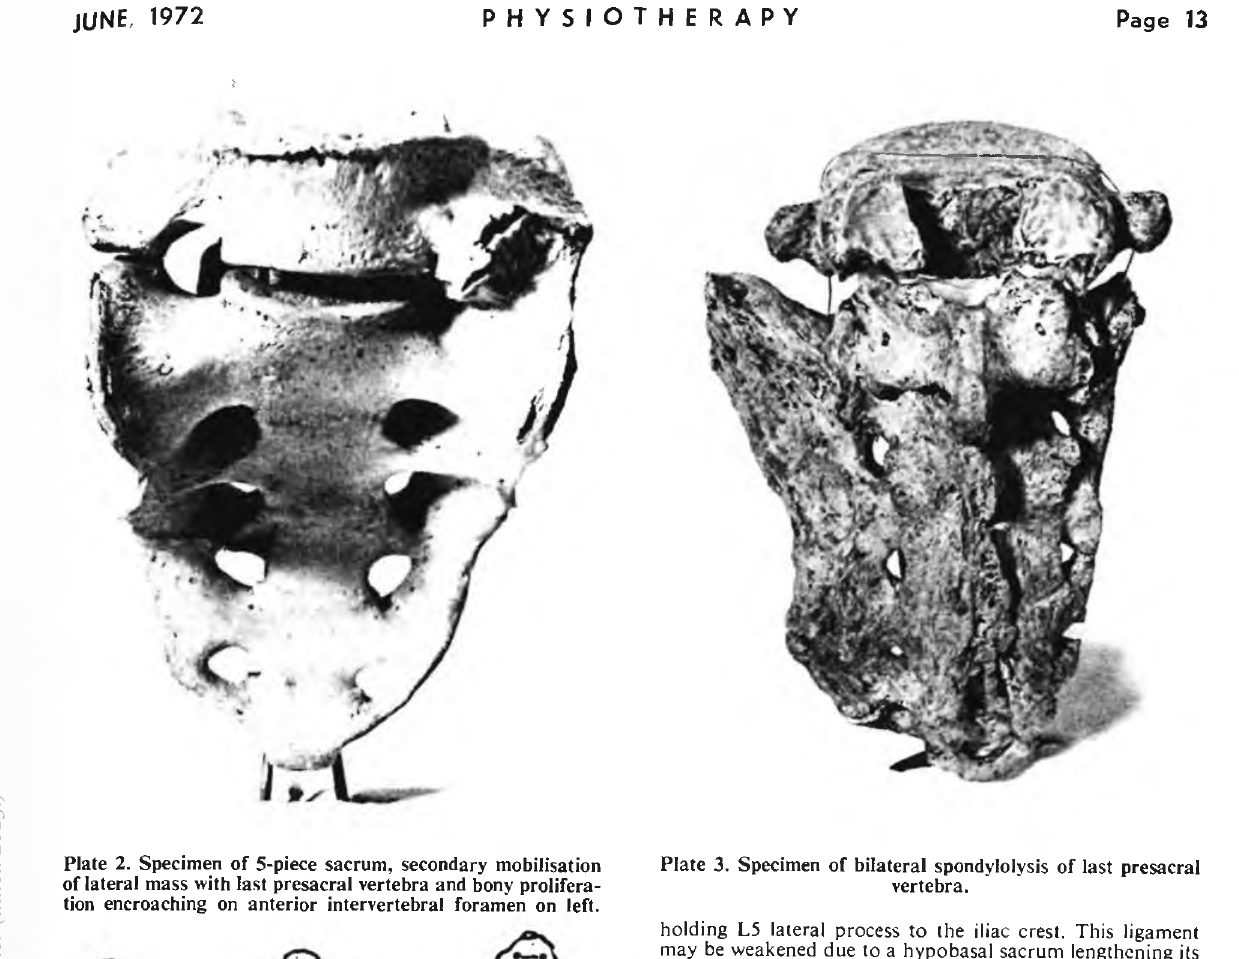
Fig. 8. Diagram showing hyperbasal, homobasal and hypobasal